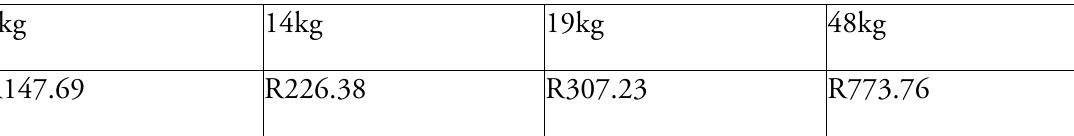
Table 6: Price of gas (excluding value added tax)